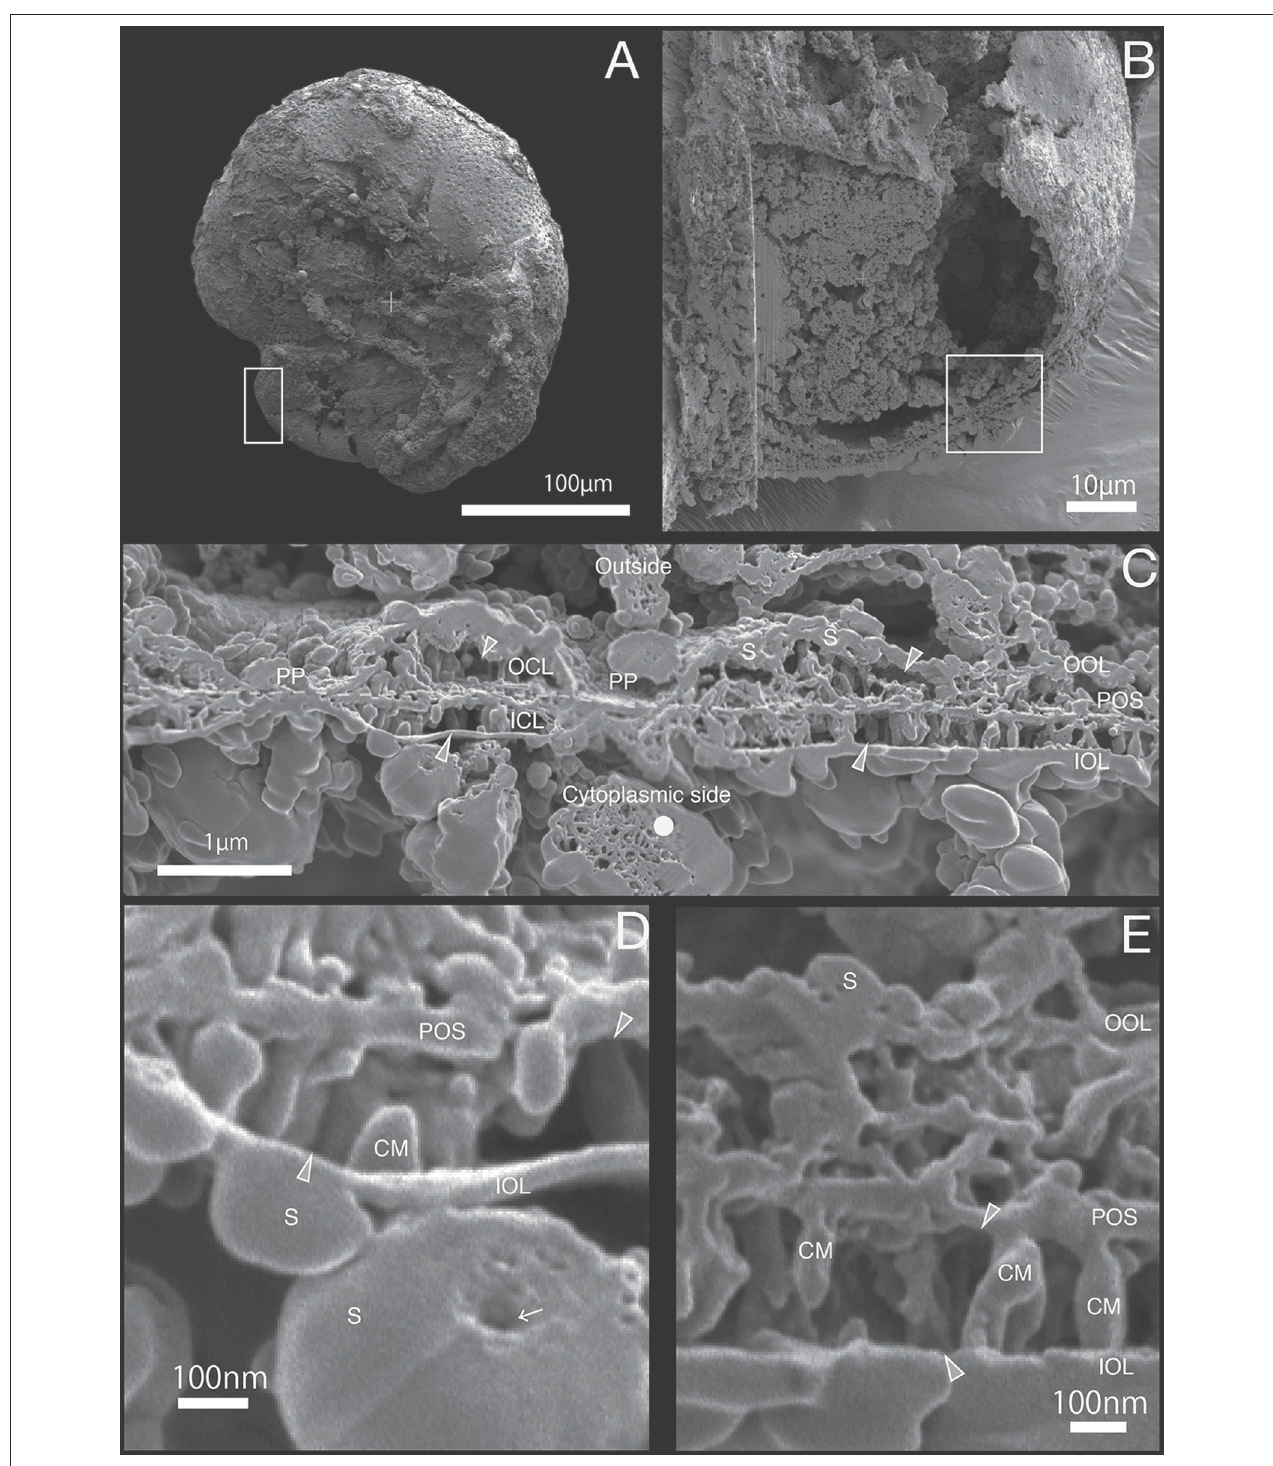
FIGURE 3 | SEM images of specimen #2. (A) Overview. The white rectangle indicates the obseved newly calcifing chamber. (B) The newly calcified chamber (white rectangle in (A) . The field of FIB processing is indicated by the white rectangle. (C) Composite SEM image of the FIB processed SOC. Upper side is the outside and whereas the lower side is the cytoplasmic side. The white dotted line in the calcareous layer indicates the boundary between outer side and cytoplasmic side of calcareous layer. (D) Magnified image of small calcareous materials. (E) Higher magnification showing the details of SOC. OOL, outer organic layer; OCL, outer calcareous layer; POS, primary organic sheet; ICL, inner calcareous layer; IOL, inner organic layer; S, spherical structures; CM, calcareous materials; PP, pore plate; gray triangles, void; white arrows, cavities; white dot, sponge like structure.